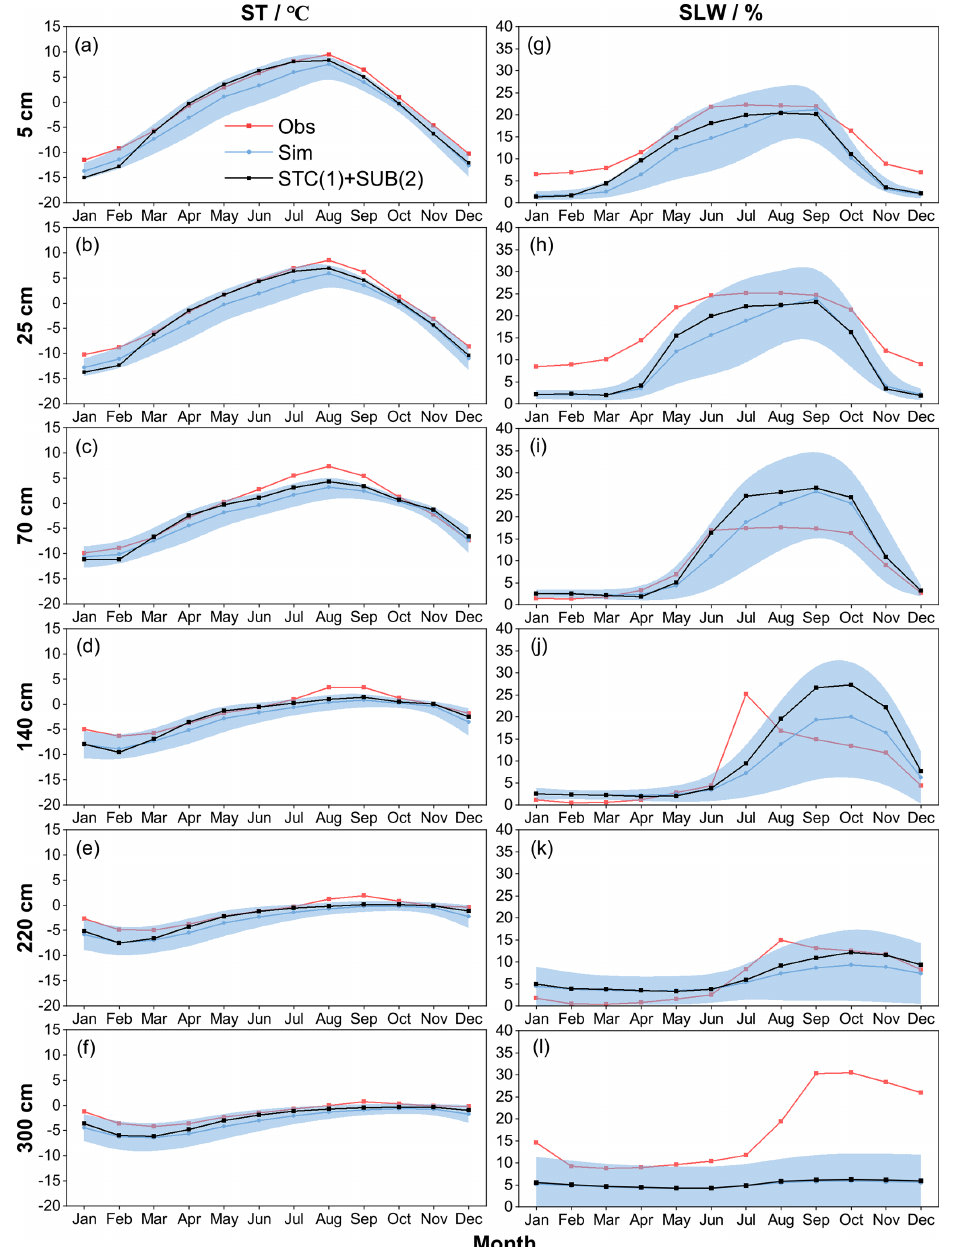
Figure 3. Monthly soil temperature (ST, in ◦ C) and soil liquid water (SLW, in %) at (a, g) 5cm, (b, h) 25cm, (c, i) 70cm, (d, j) 140cm, (e, k) 220cm and (f, l) 300cm at the TGL site. The light blue shading represents the standard deviation of the ensemble simulation. The black line and the symbols represent the ensemble mean of simulations with STC(1) and